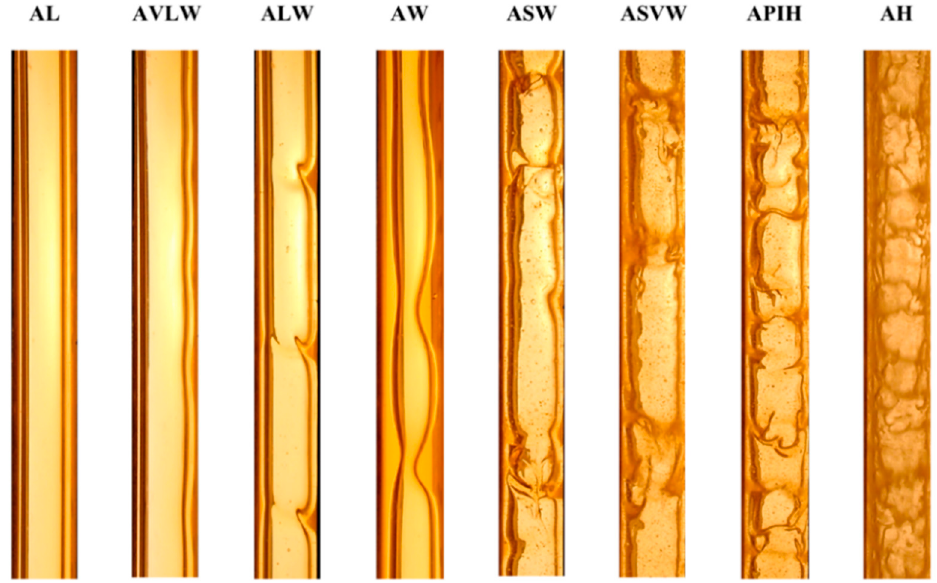
Figure 8. Flow patterns accompanying co-current downward gas-very viscous liquid flow: AL— smooth film, AVLW—film with very light waves, ALW—film with light waves, AW—wavy film, ASW—very wavy film, AVSW—very wavy film, APIH—transient hydraulic flow, AH—hydraulic